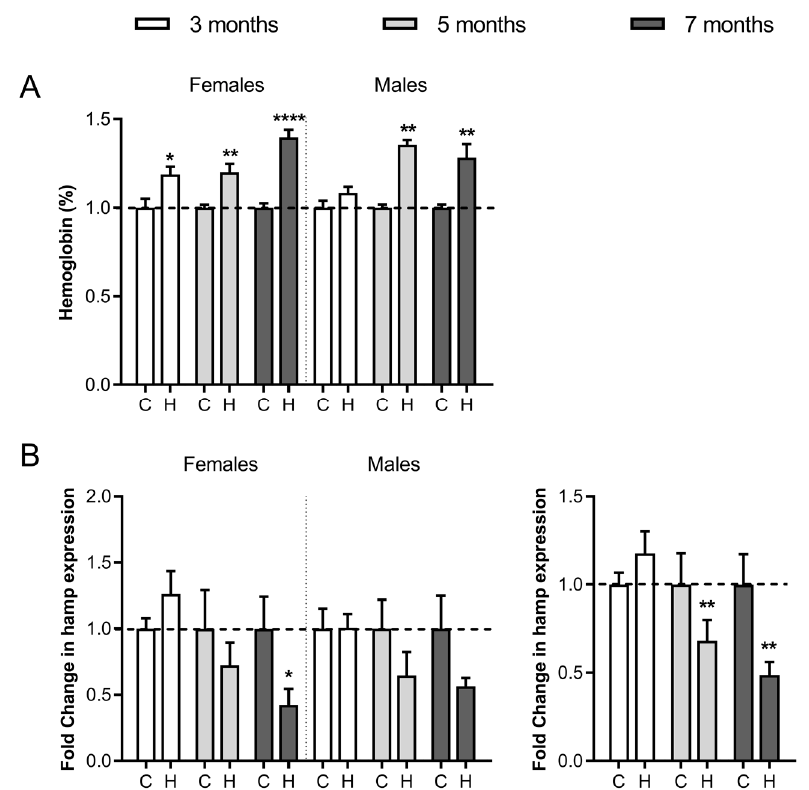
Figure 2. Haemoglobin levels and mRNA hepcidin expression in Hfe − / − mice. ( A ) Normalised haemoglobin concentration in peripheral blood. ( B ) mRNA expression of hepatic hepcidin at 3, 5 and 7 months in Hfe − / − (H) and wild type (C) female and male mice. Hamp (hepcidin gene) mRNA expression is also shown without gender separation (bottom right). The data for each Hfe − / − mouse were normalised to controls of the same age and sex (indicated by dotted lines). Representative graphs show mean ± SEM from 2 independent experiments (each experiment n = 6 per bar/sex group). Statistical significance is indicated as **** p < 0.0001, ** p < 0.01 and * p < 0.05 in comparison to age- and sex-matched controls.